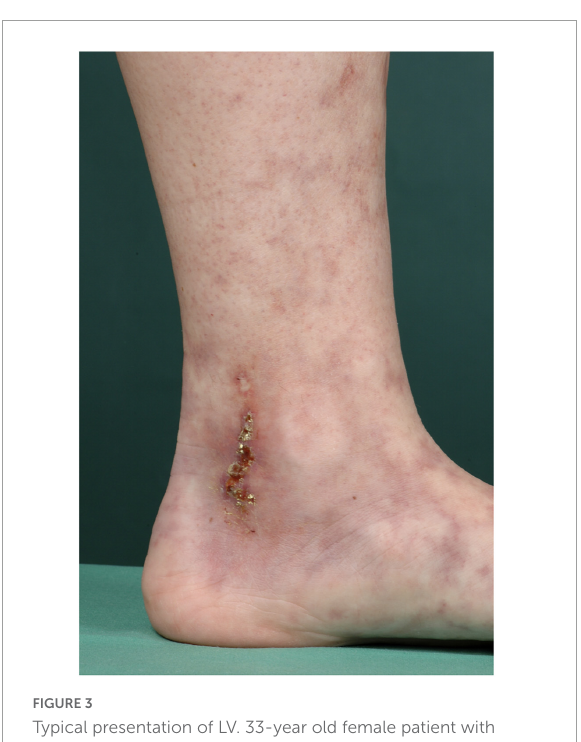
FIGURE3 Typical presentation of LV. 33-year old female patient with typical presentation of LV: Livedo racemosa , ulcers and Atrophie